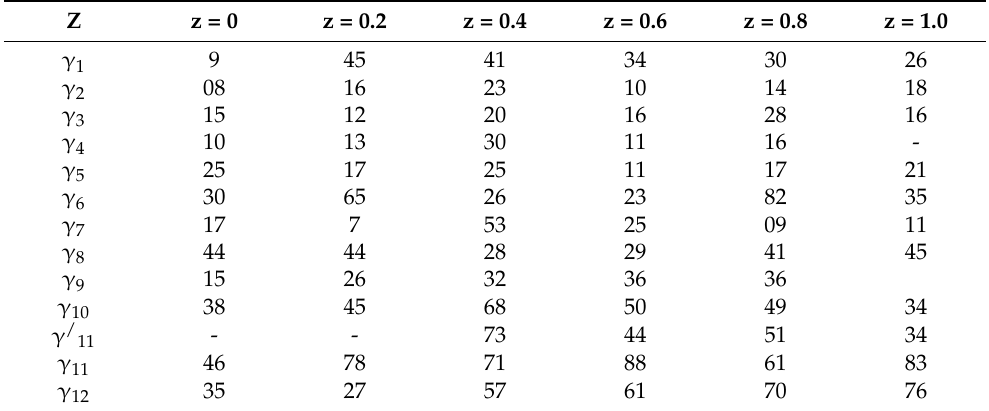
Table 4. Calculated parameters of damping factor γ TO of transverse optical phonon modes for the